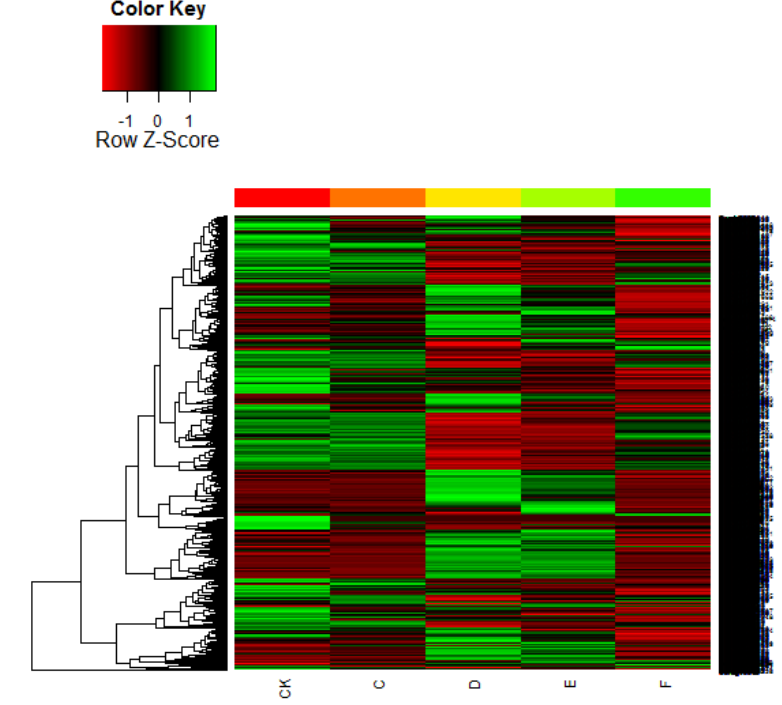
Figure 3. Changes in gene expression among drought-stress stages and re-watering. Heat-map of the total differentially expressed genes. Columns and rows in the heat maps represent samples and genes, respectively. Sample names are displayed below the heat maps. CK represents the control; C, D, and E represent the three drought treatment levels; F represents re-watering. Colour scale indicates fold changes in gene expression. A fold change of ≥1 is shown in green (increased transcript abundance), a fold change of ≤ −1 is shown in red (decreased transcript abundance), and no change is indicated in